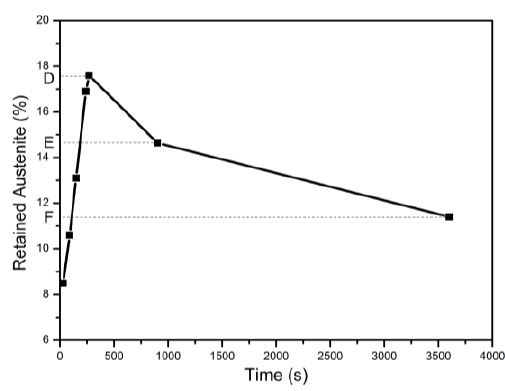
Figure 4. The relationship between retained austenite and partitioning time.